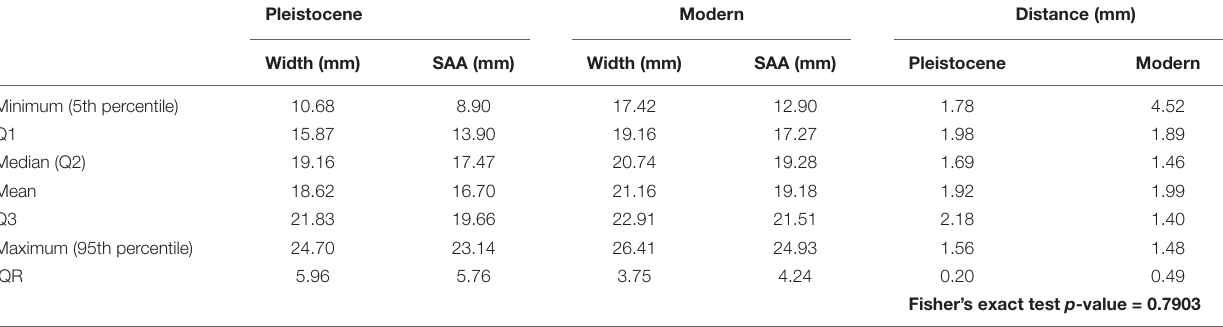
TABLE 3 | Metrics used to compare the relative position of body size (width) and SAA between Pleistocene and modern samples. Pleistocene Modern Distance